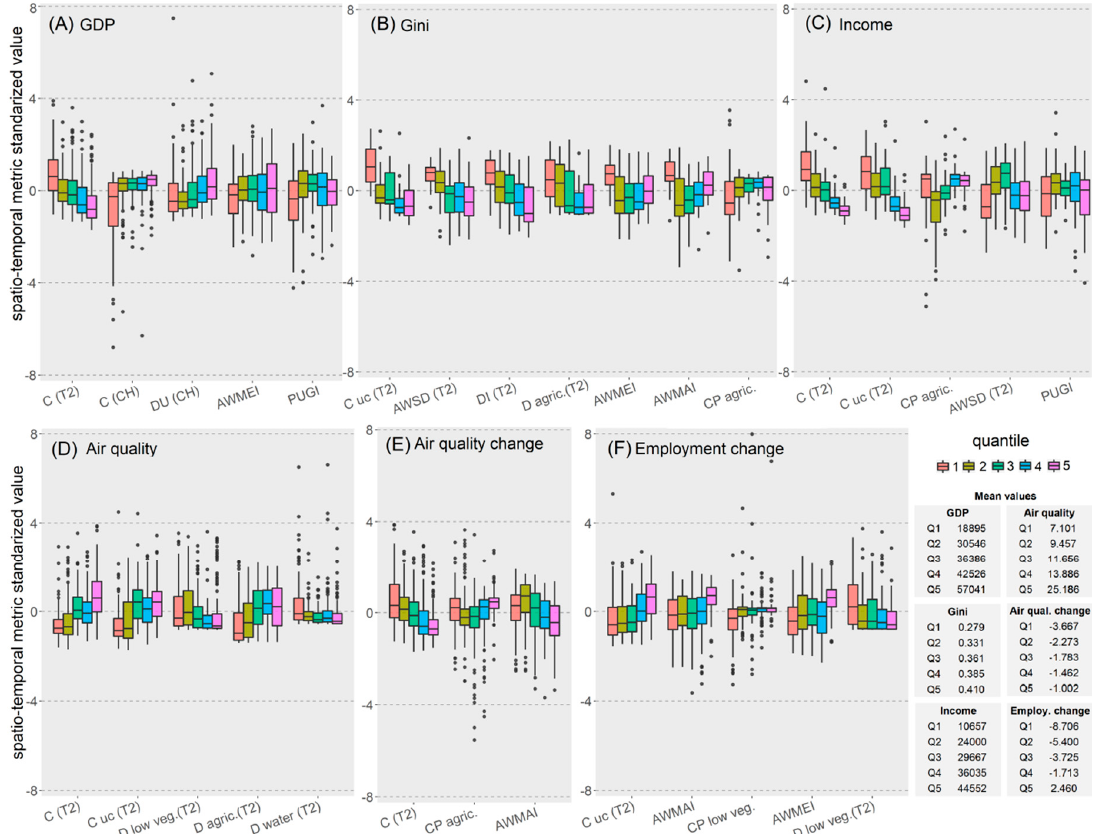
Figure 6. Boxplots of selected relevant spatio-temporal metrics sorted according to their importance. The socio-economic variables: ( A ) GDP; ( B ) Gini; ( C ) income; ( D ) air quality; ( E ) air quality change; and ( F ) employment rate change, are divided into five quantiles (Q1 to Q5, from low to high values), and the standardized values of the metrics are shown for each quantile. The table on the bottom-right shows the mean values of the socio-economic variables per quantile. Air quality measures the fine particulate matter (higher values mean more pollutants and lower air quality). The units are GDP and income, USD; Gini, ratio; air quality, µg/m³; and employment, %.